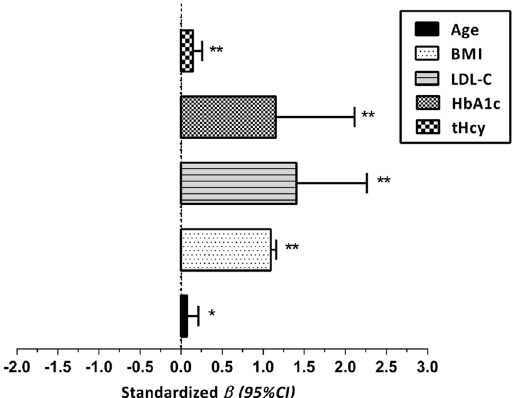
Figure 2. Association of metabolic risk variables with TBF/CI. TBF/CI: total body fat/conicity index; BMI: body mass index; LDL-C: low-density lipoprotein-cholesterol; HbA1c: hemoglobin A1c; tHcy: total homocystein. Linear Regression without adjustment: * P < 0.05, ** P < 0.001.